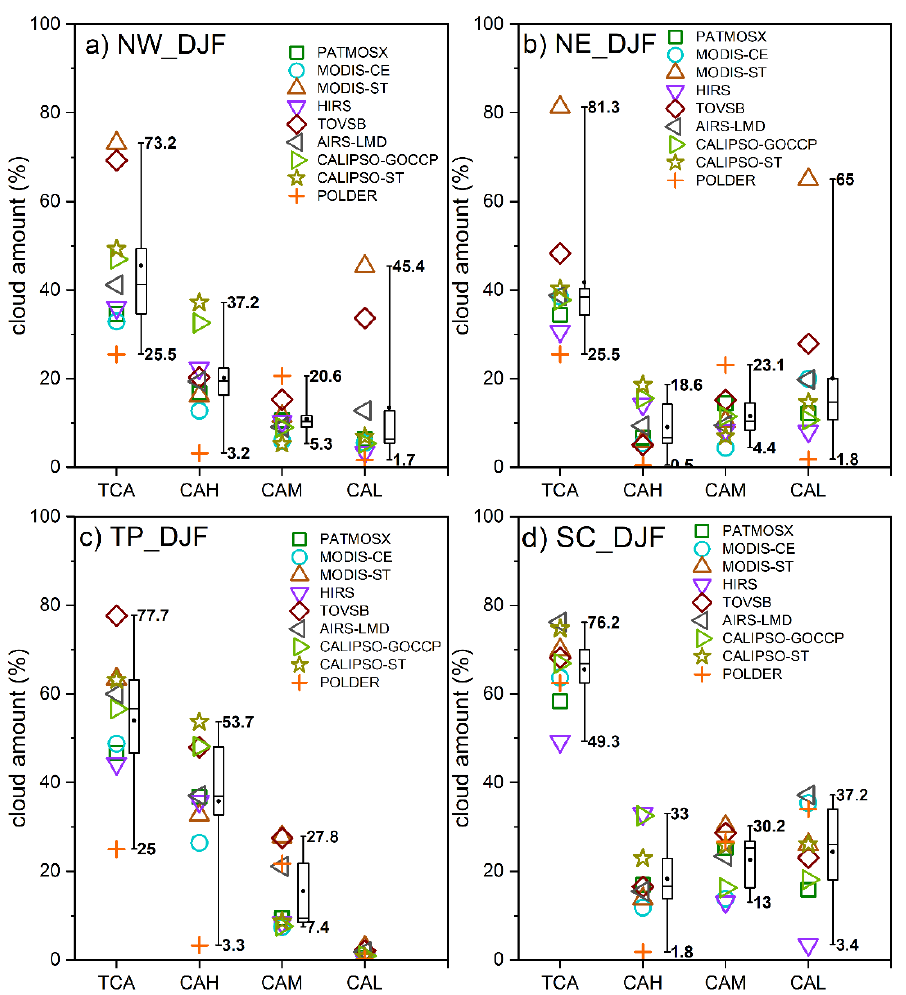
Figure 5. Averaged winter total cloud amount (TCA), high-level cloud amount (CAH), mid-level cloud amount (CAM), and low-level cloud amount (CAL) at 13:30 local time across different satellite datasets over four subregions of China: ( a ) NW region; ( b ) NE region; ( c ) TP region; and ( d ) SC region (unit: %), with symbols marked for different datasets. The box – whisker plot shows the maximum, minimum, upper quartile, lower quartile, and median for all datasets, and the black dots represent the algorithm mean. The specific values of the maximum and minimum values are also marked on the box – whisker plot.